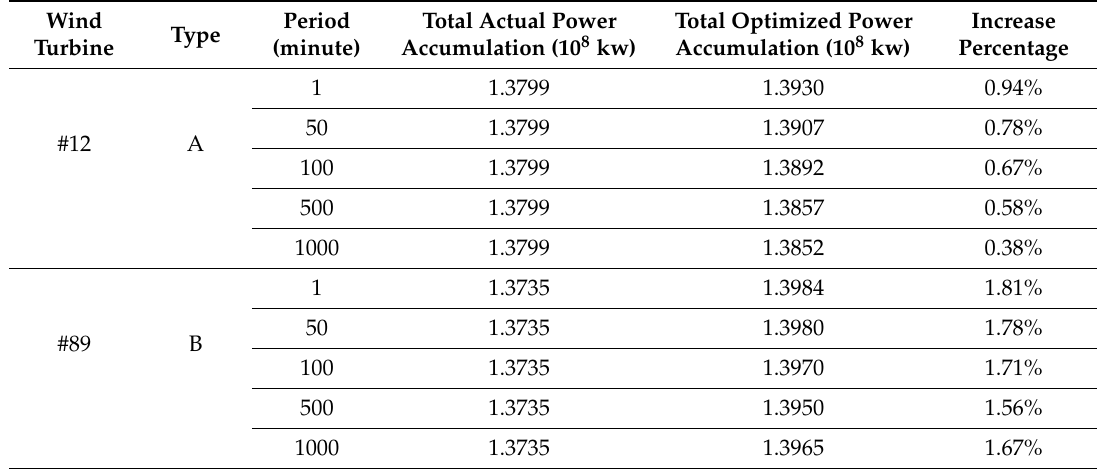
Table 9. Power optimization on #12, #89 under a di ff erent